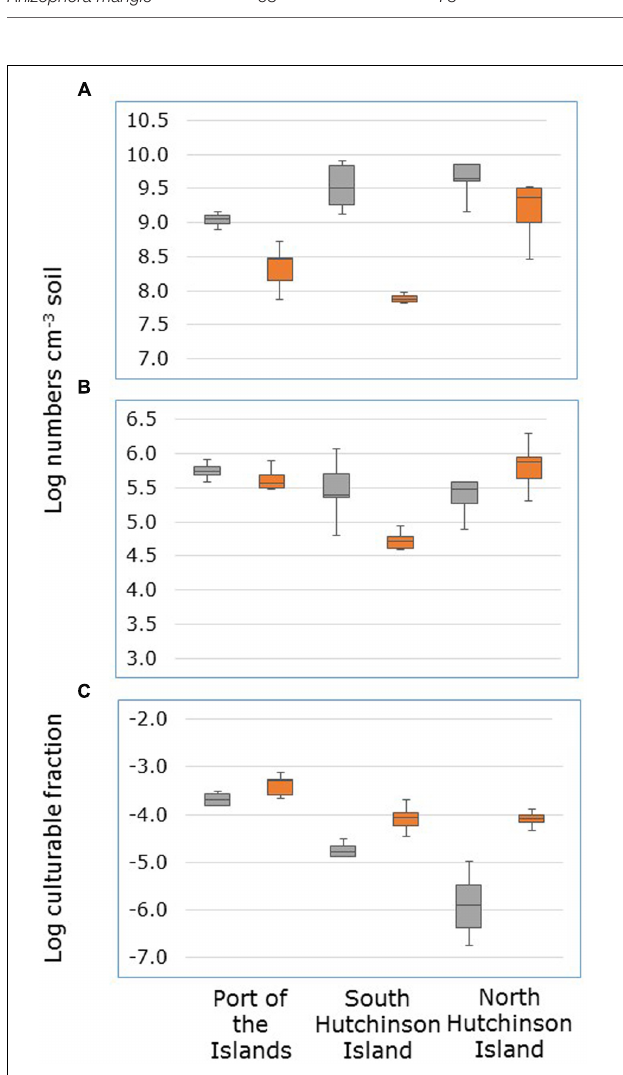
FIGURE 2 | Numbers of dsrB gene copies (A) numbers of sulfate-reducing cells able to grow on liquid medium with acetate, propionate, lactate (APL medium) (B) and the fraction of dsrB gene-containing cells able to grow on APL medium (C) in soil samples collected from Avicennia germinans (gray boxplots) and Rhizophora mangle stands (orange boxplots) at Port of the Islands, South Hutchinson Island and North Hutchinson Island.